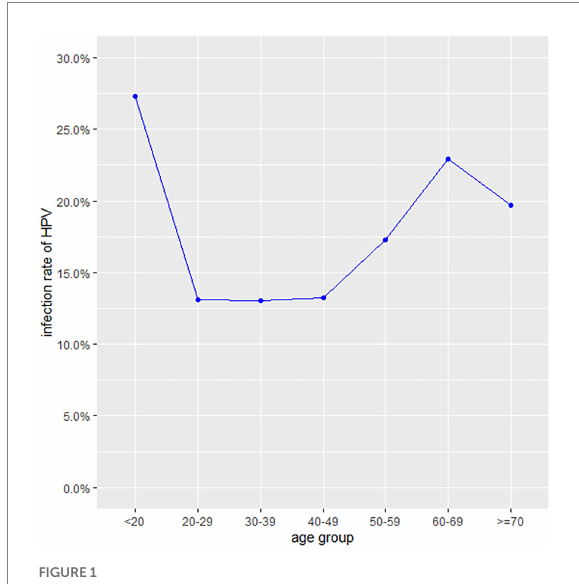
FIGURE 1 The prevalence of HPV infection in different age groups from 2018 to 2020.